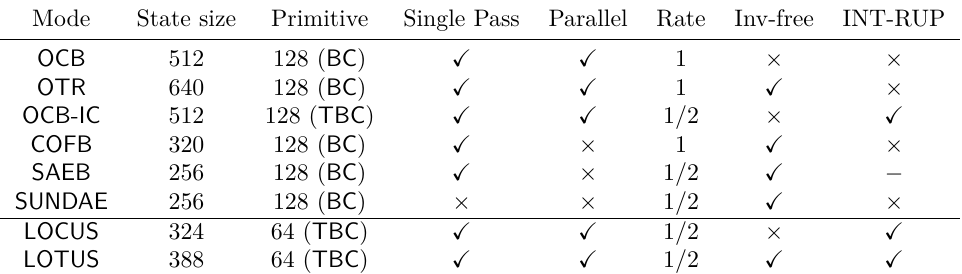
Table 1: Comparison of various Lightweight AE modes with LOTUS and LOCUS . The block sizes are chosen such that they satisfy the criteria of NIST. The key size is 128-bit in all the